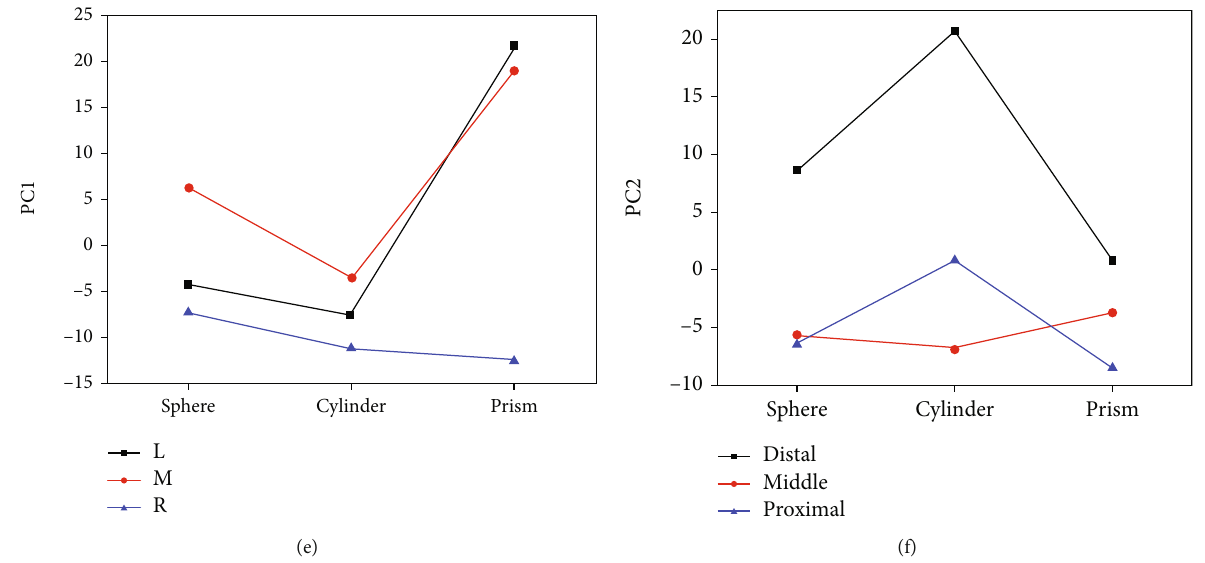
Figure 10: Two factor interaction plots: (a) shape versus X deviation for thumb Rot angle; (b) shape versus X deviation for thumb IP angle; (c) X deviation versus Y deviation for thumb MCP angle; (d) X deviation versus Y deviation for thumb ABD angle; (e) shape versus X deviation for PC1; (f) shape versus Y deviation for